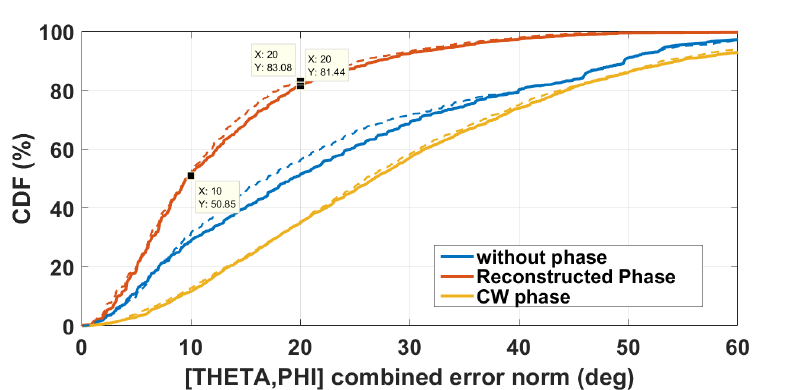
Figure 14. Cumulative Distribution Functions (CDFs) of experimental DoA estimations